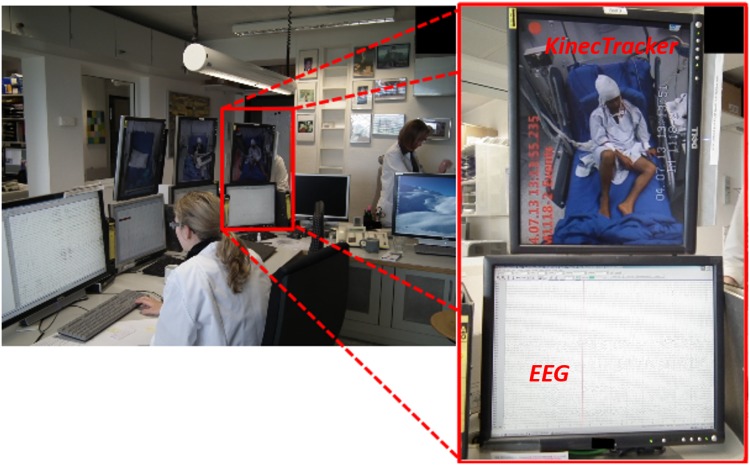
Aspects of the 3Dvideo-EEG system console installed in the routine of University of Munich EMU.Notice the KiT time-code is inserted in the video-EEG system for complete synchronization purposes. The system does not interferes with the EMU routine.